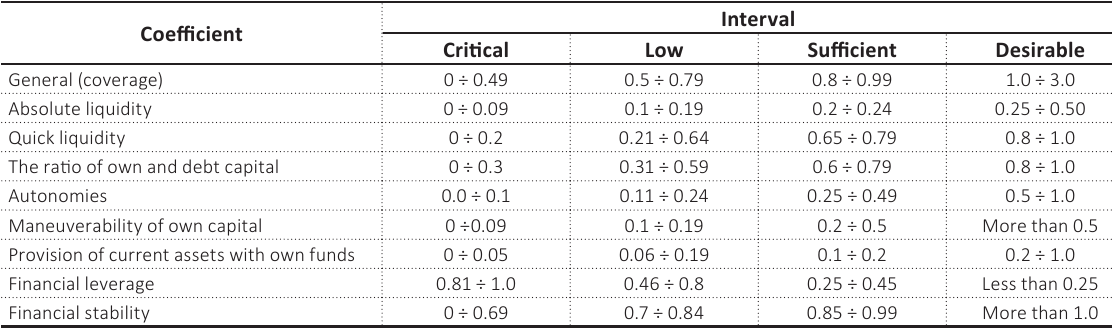
Table 1. Coefficients of solvency and financial stability